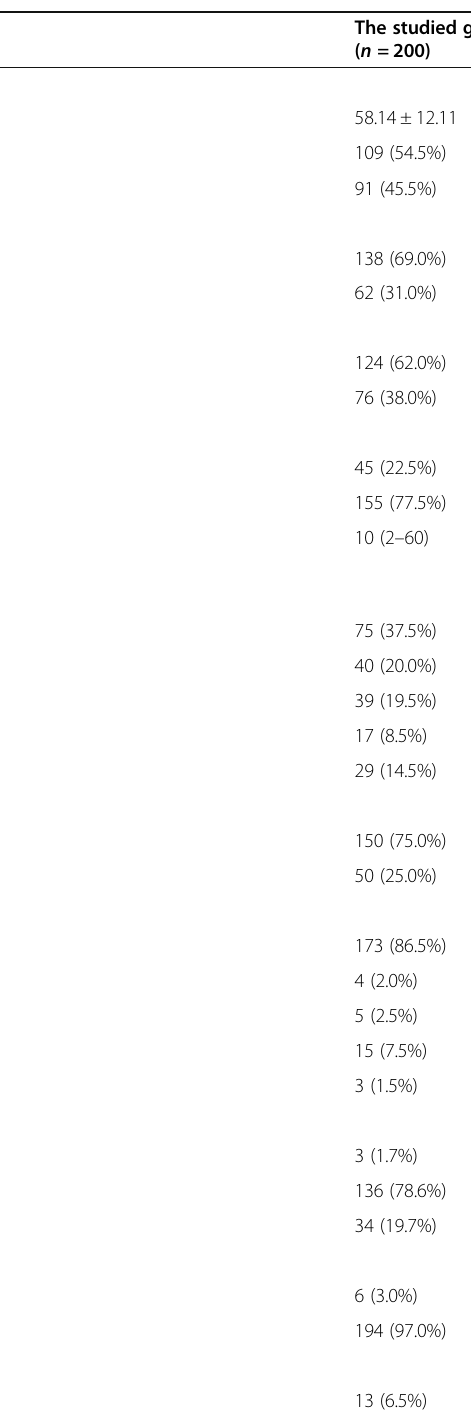
Table 1 Clinical and pathological characteristics of patient